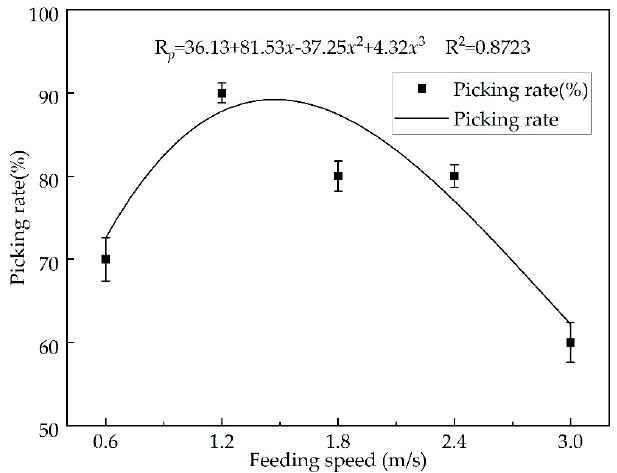
Figure 11. Results of the single-factor test of the stalk feeding speed.